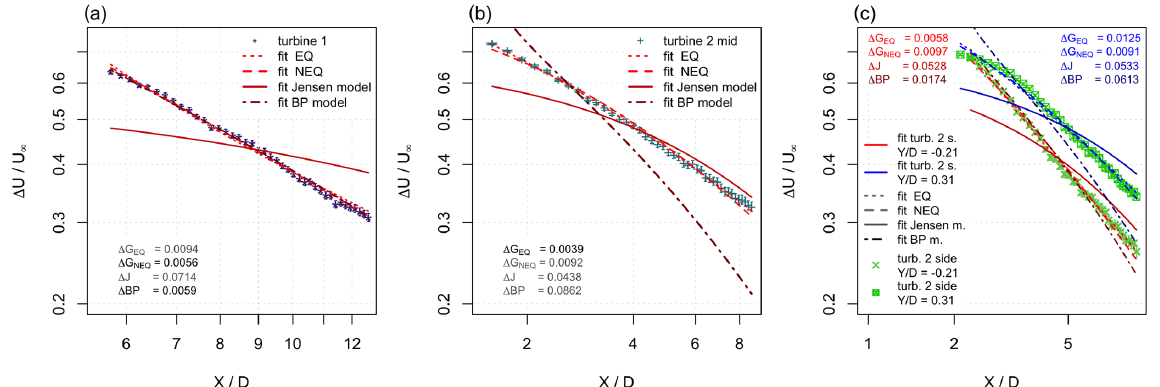
Figure 11. (cid:49)U/U ∞ for the three different inflow conditions at the spanwise position Y/D = − 0 . 21: (a) turbine 1 – laminar inflow, (b) tur- bine 2 mid – turbulent, and (c) turbine 2 side – turbulent and intermittent. Different models are fitted to the recovery region, and the residual standard errors are presented. Note that the axes are